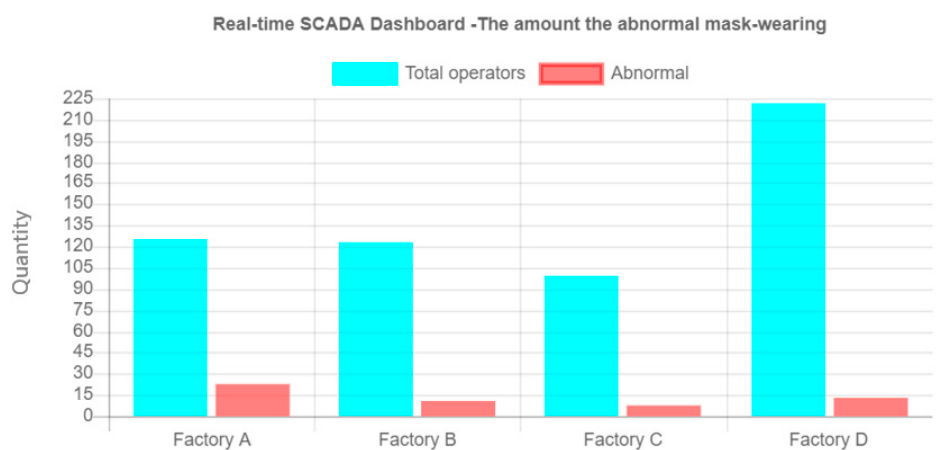
Table 3. Results of the trained model.